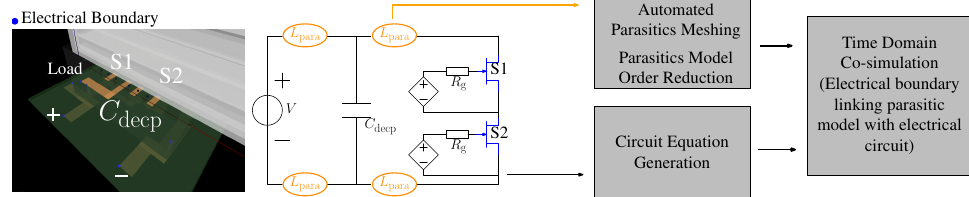
Figure 4. Simulation technique used in PEVP